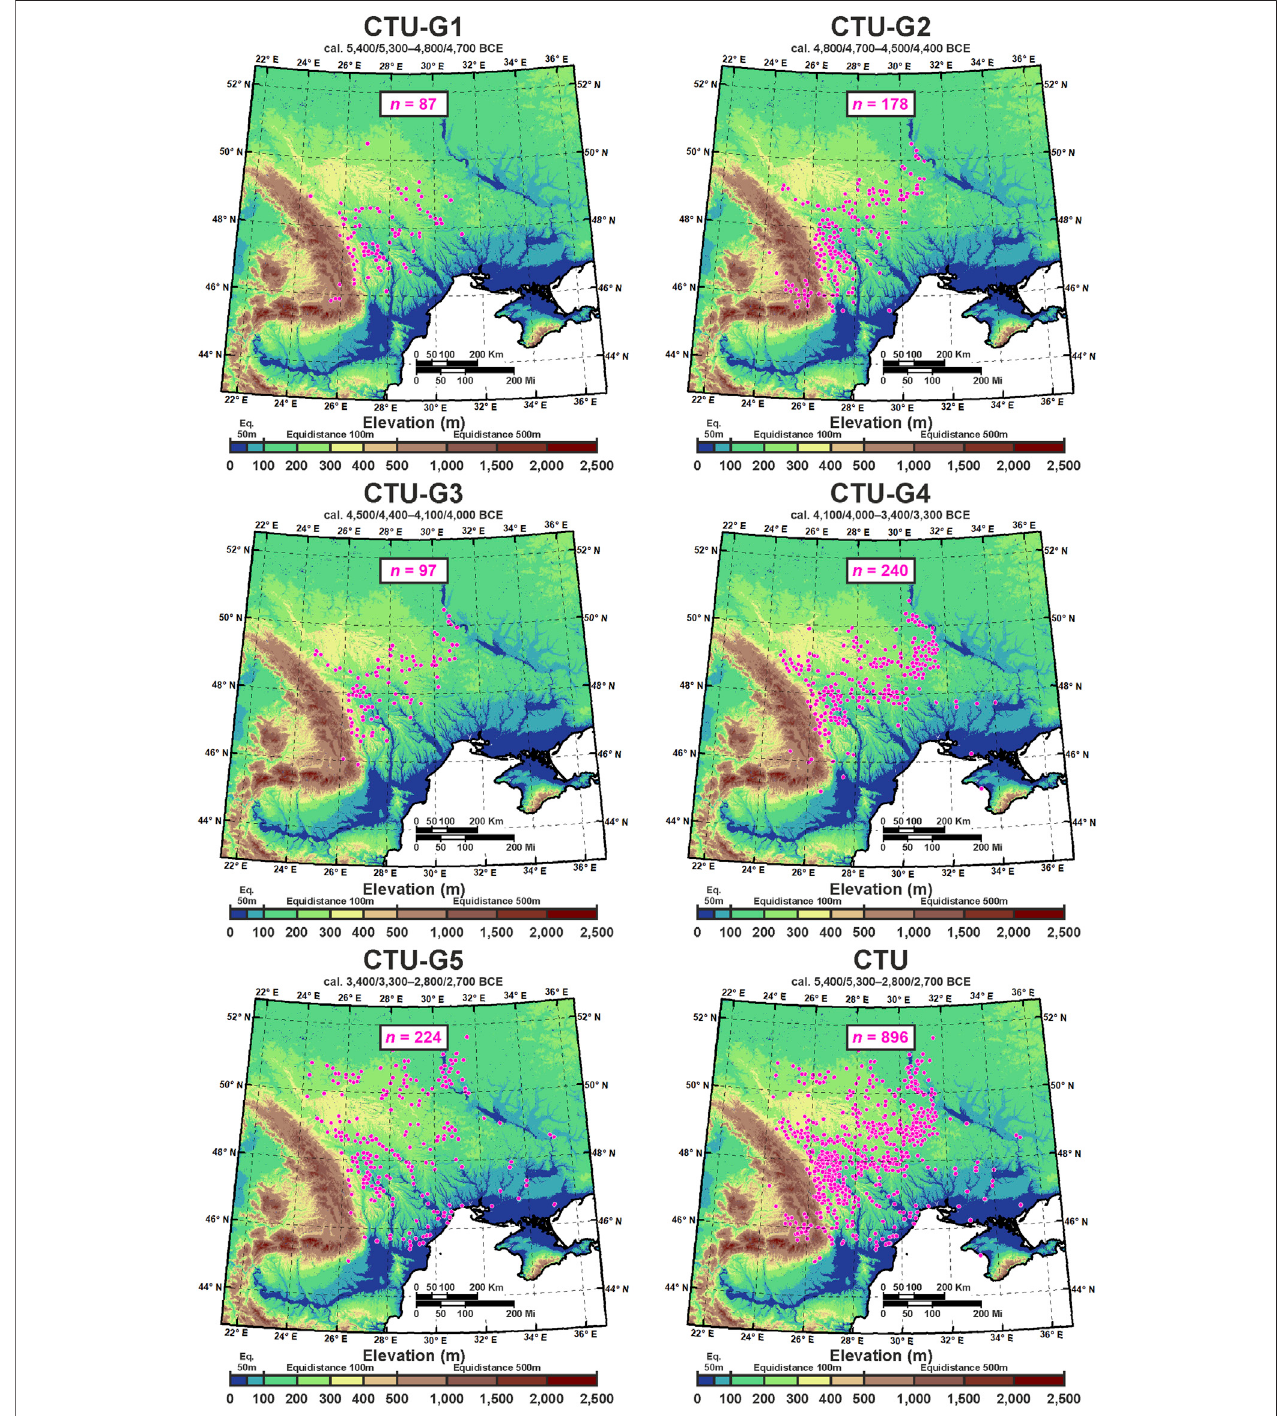
FIGURE3| CTUgroups ’ (see Table1 )andtotalCTUsites ’ distributionwereusedtoruntheECNM;duplicatesiteoccurrencesfromeachgridcellwereremovedto reduce potential bias.